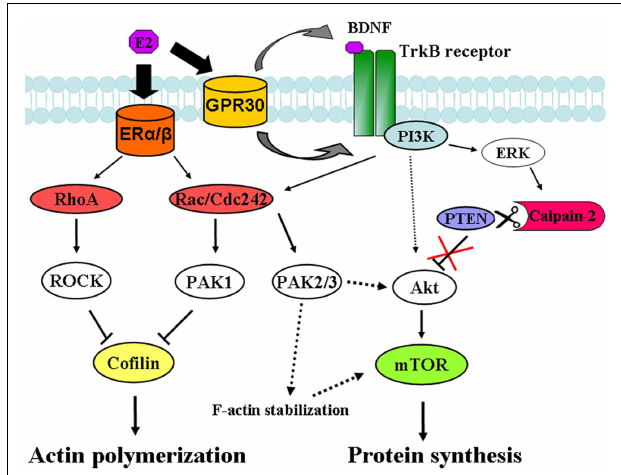
FIGURE 10 | Signaling pathways involved in estradiol regulation of protein synthesis and actin polymerization in hippocampal neurons . Estradiol action on classical ER α and ER β activates both RhoA/ROCK and Rac/Cdc42/PAK1 signaling pathways leading to cofilin inactivation and stimulation of actin polymerization. On the other hand, estradiol action on non-classical ER, GPR30 inducesTrkB receptor activation, which triggers ERK-dependent calpain-2 activation leading to PTEN cleavage and subsequent stimulation of the Akt/mTOR-mediated protein synthesis. In addition, activation of PAK2/3 signaling by BDNF and estradiol contributes to Akt stimulation and/or supports F-actin stability, which is necessary for mTOR